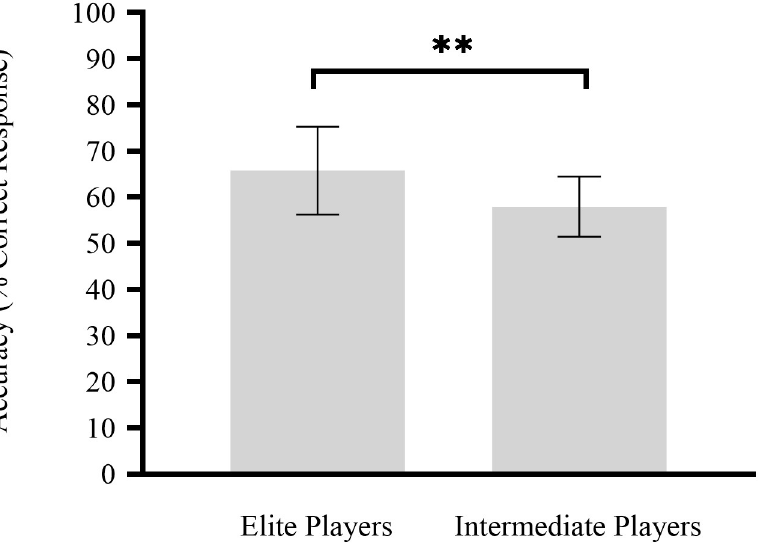
Fig 2. Attention as assessed in ice-hockey players performing the multiple object tracking task. �� p < 0.01.